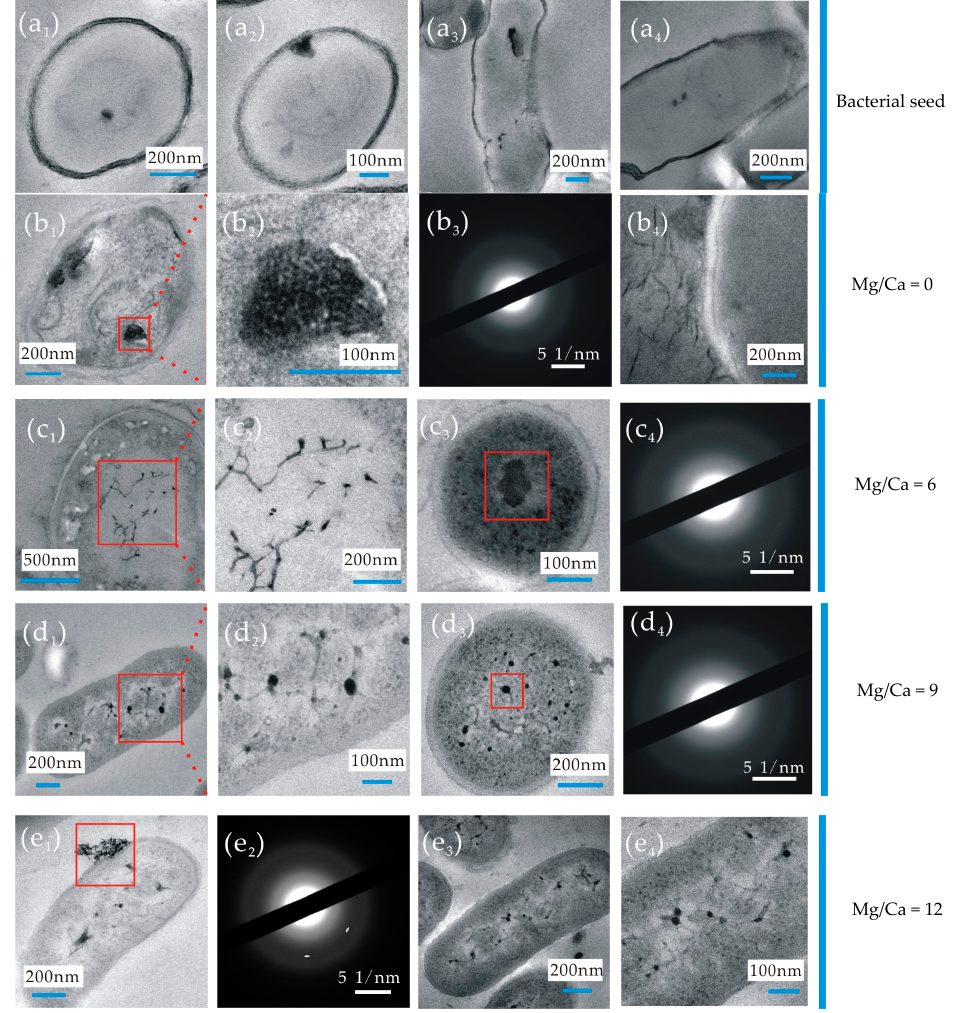
Figure 8. High-resolution transmission electron microscopy (HRTEM) and selected area electron diffraction (SAED) analyses of the ultra-thin slices of B. subtilis J2 bacteria.